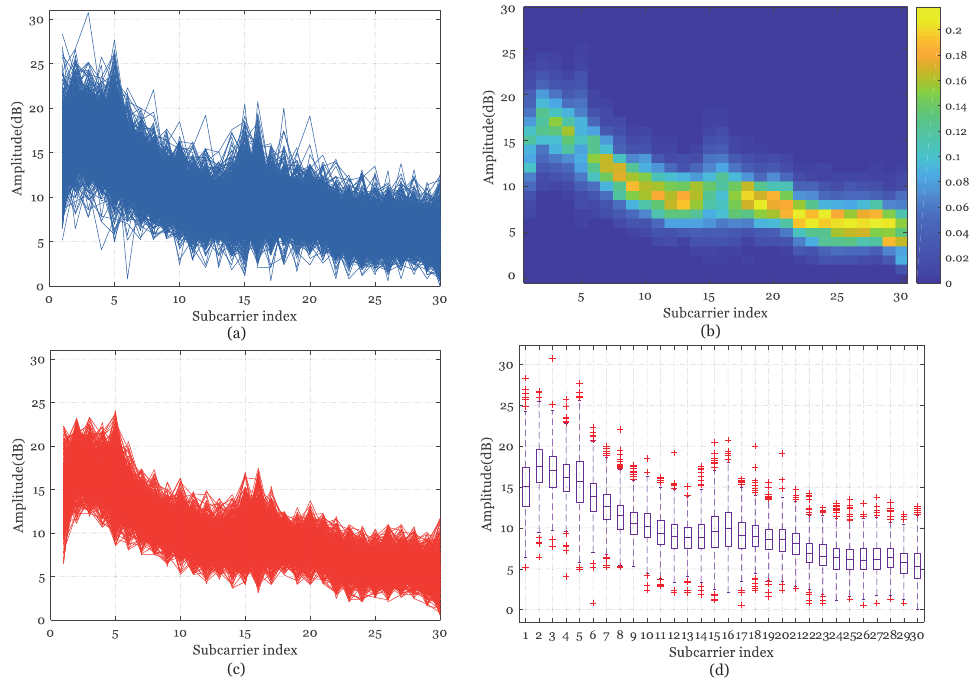
Figure 3. CSI amplitude outlier filtering processing at position 3 in scenario 3 (Integrated non line of sight (NLOS) room). ( a ) The Raw CSI amplitude. ( b ) The distribution heat map of the amplitude probability. ( c ) The Processed CSI amplitude. ( d ) The boxplot diagram of raw CSI